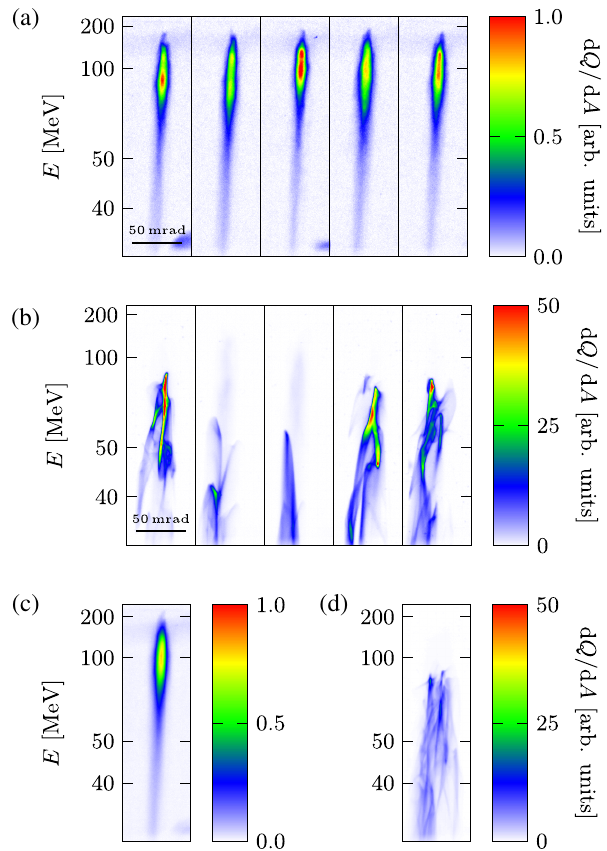
FIG. 1. False-color images of five electron beams emerging from (a) H 2 and (b) He dispersed by a permanent dipole magnet. In both cases, a 2 mm nozzle was used at a fixed backing pressure of 9.5 bar. The reproducibility of the data is shown by the average of ten individual images of electron spectra for beams emerging from (c) H 2 and (d) He. All color scales are normalized to the maximum signal in (a).